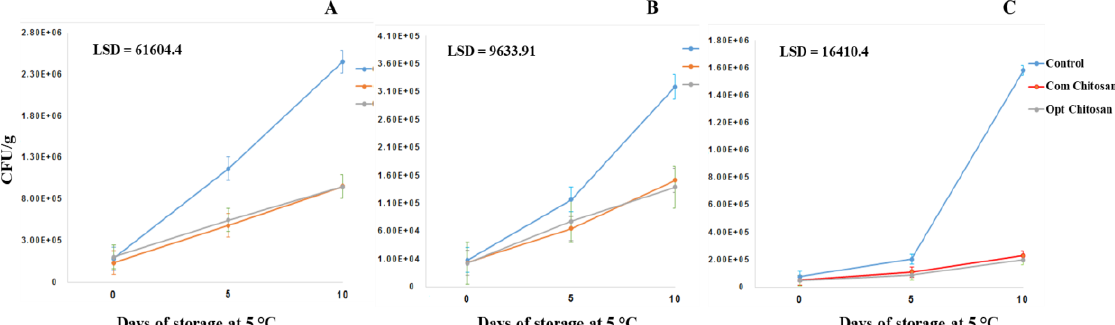
Figure 7. Counting of mesophilic ( A ), psychrophilic ( B ), molds and yeasts ( C ) microorganisms during storage at 5 °C of papaya slices that had been previously dipped in a chitosan solution. Control = fresh-cut papaya slices without application of chitosan film; Quit Com = fresh-cut papaya slices with application of commercial chitosan film; Quit Opt = fresh-cut papaya slices with application of chitosan film obtained under optimized lactic fermentation conditions. Each point represents the mean of 9 repetitions. Vertical bars indicate LSD ( p ≤ 0 .05).